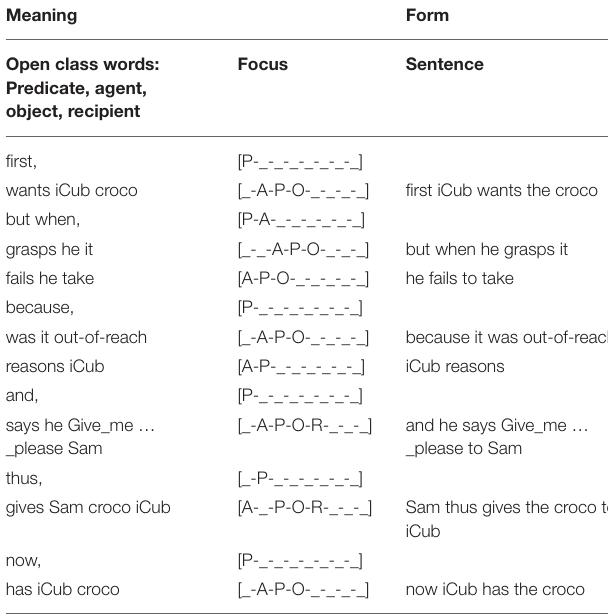
TABLE 8 | Automatically generated